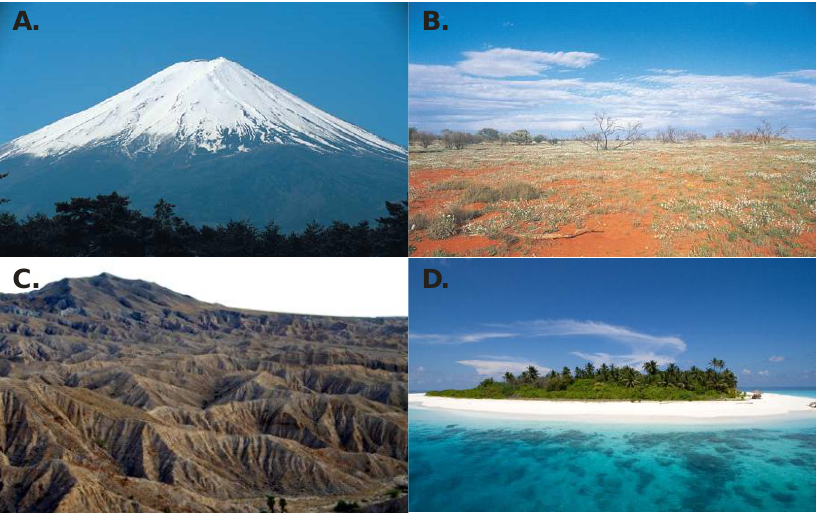
Figure 1. Four metaphors for the adaptive landscape. ( A ) Fisherian single adaptive peak; ( B ) Kimuran nearly flat landscape; ( C ) Wrightian rugged landscape; ( D ) an island peak where what is below the surface matters.